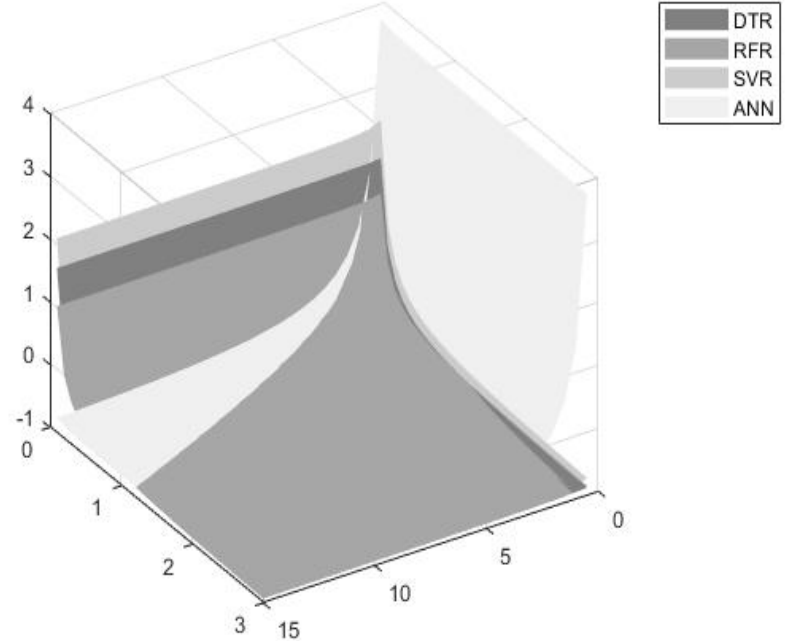
Figure 8. Sensitivity analysis of accuracy and time threshold values with w a = 70%, 1 − w a = 30%.